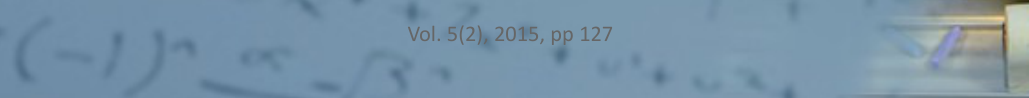
Vol. 5(2), 2015, pp